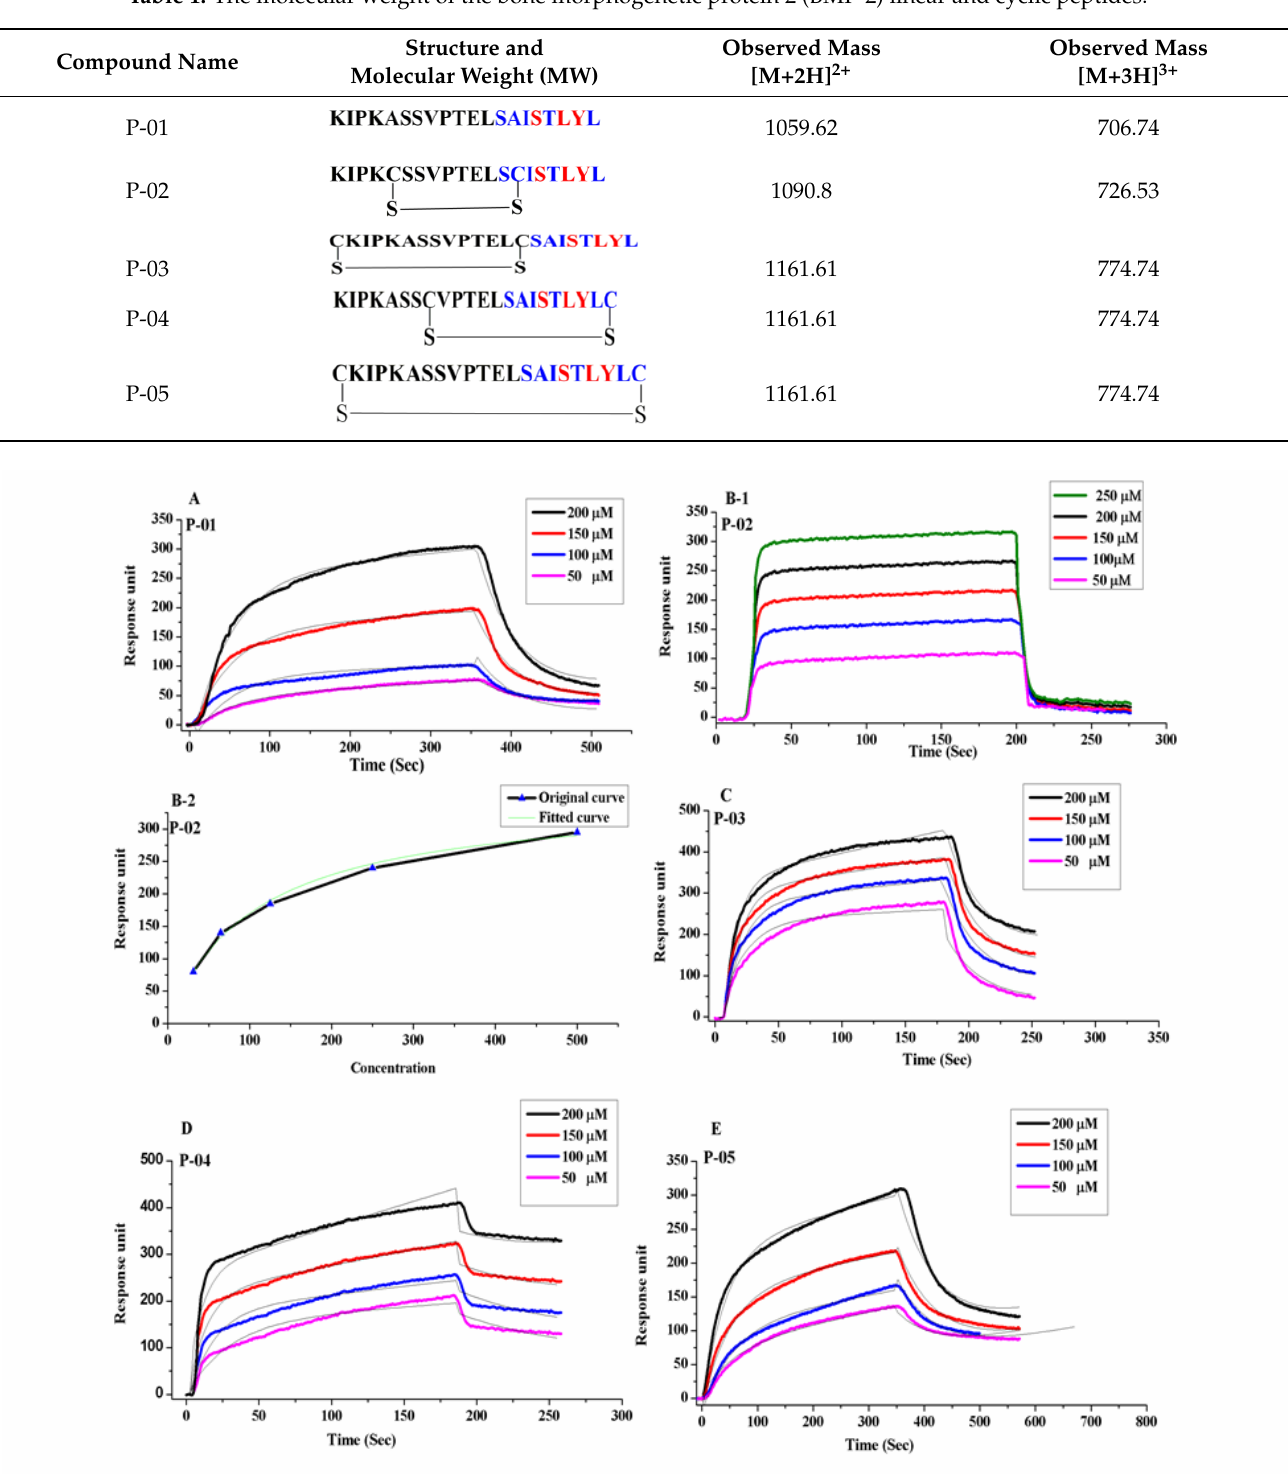
Figure 2. Surface plasmon resonance (SPR) sensograms of the peptides binding with immobilized BMPRII on the chip surface. ( A ) P-01; ( B-1 ) P-02; ( B-2 ) P-02 fitted curve; ( C ) P-03; ( D ) P-04; ( E )